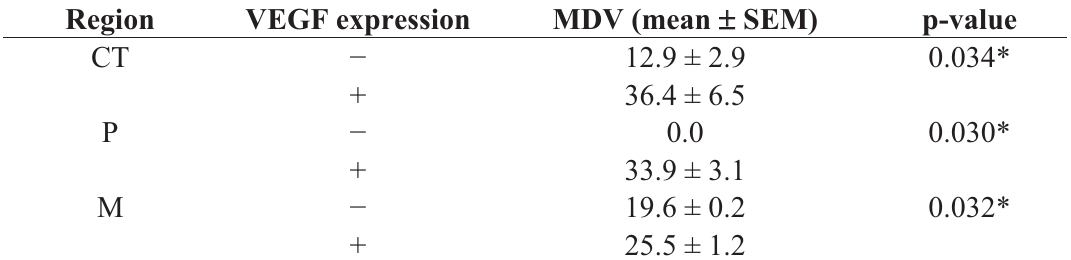
Table 2. Relationship between MVD and VEGF expression in different regions of GITC.